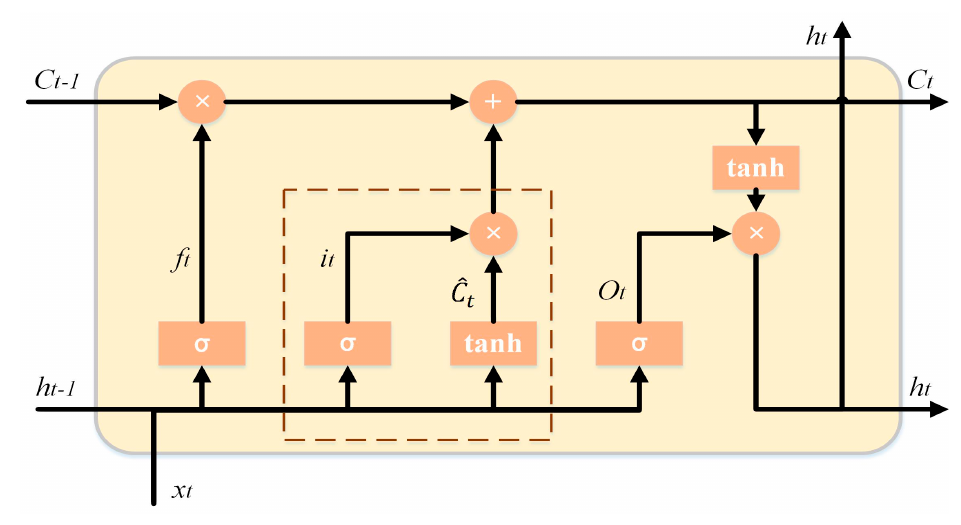
Figure 3. Diagram of the input gate structure of LSTM.